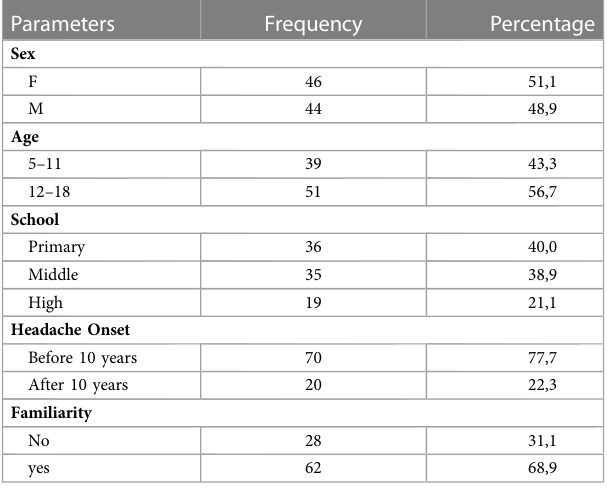
TABLE 3 Population characteristics.